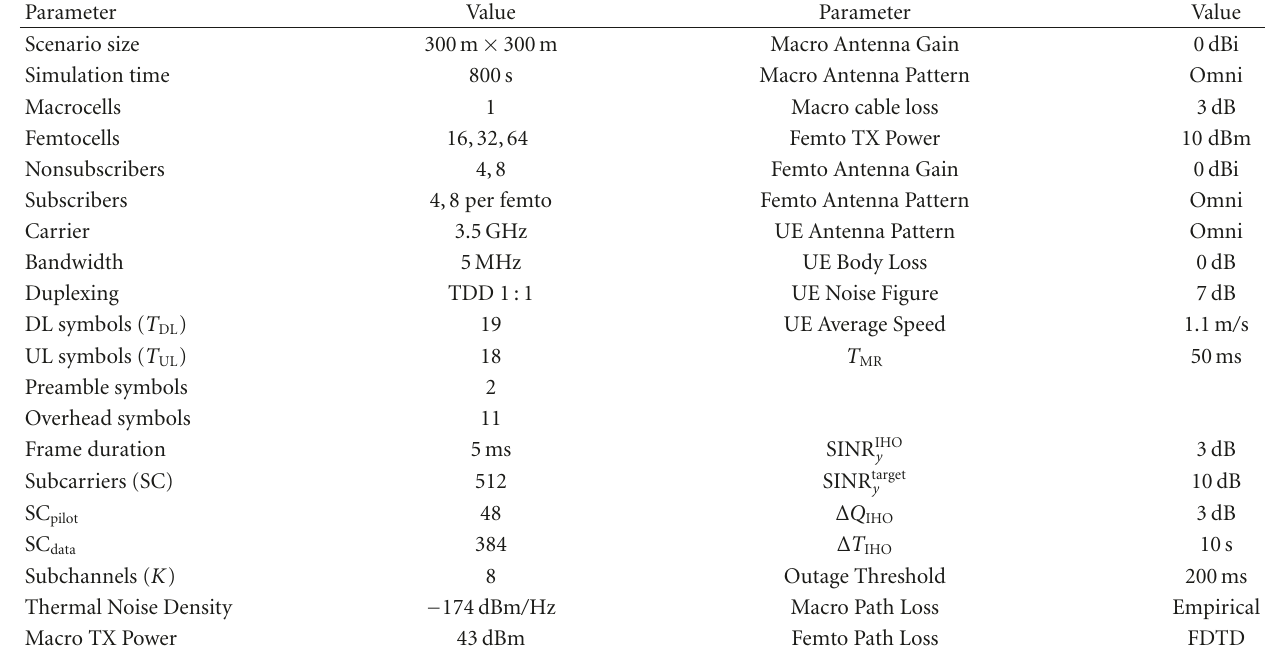
Table 3: Simulation parameters.